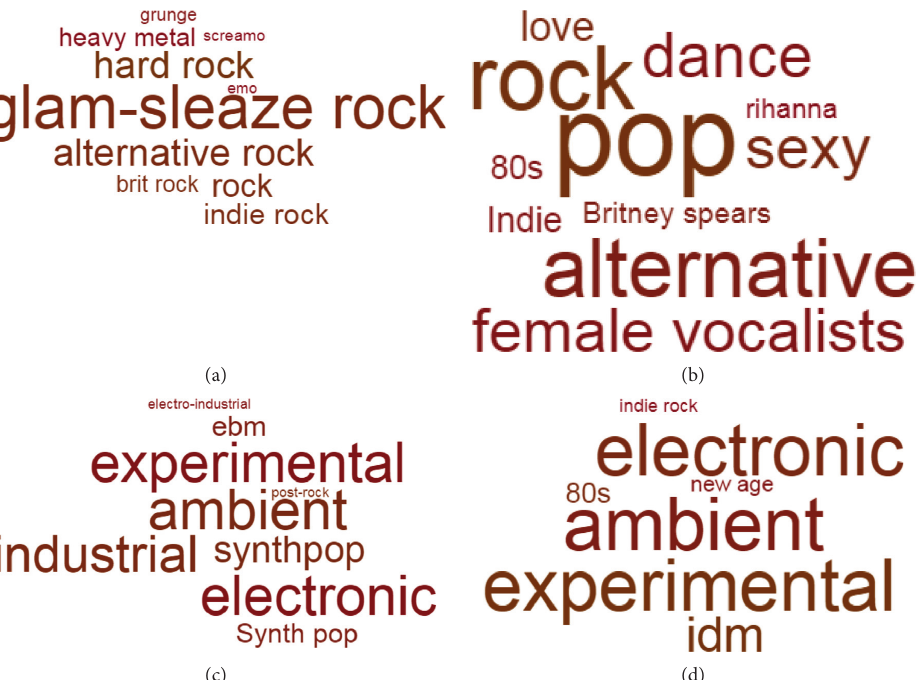
Figure 9: The examples show the word clouds of the main attributes of communities. The sizes of word indicate the probability that they belong to a topic.